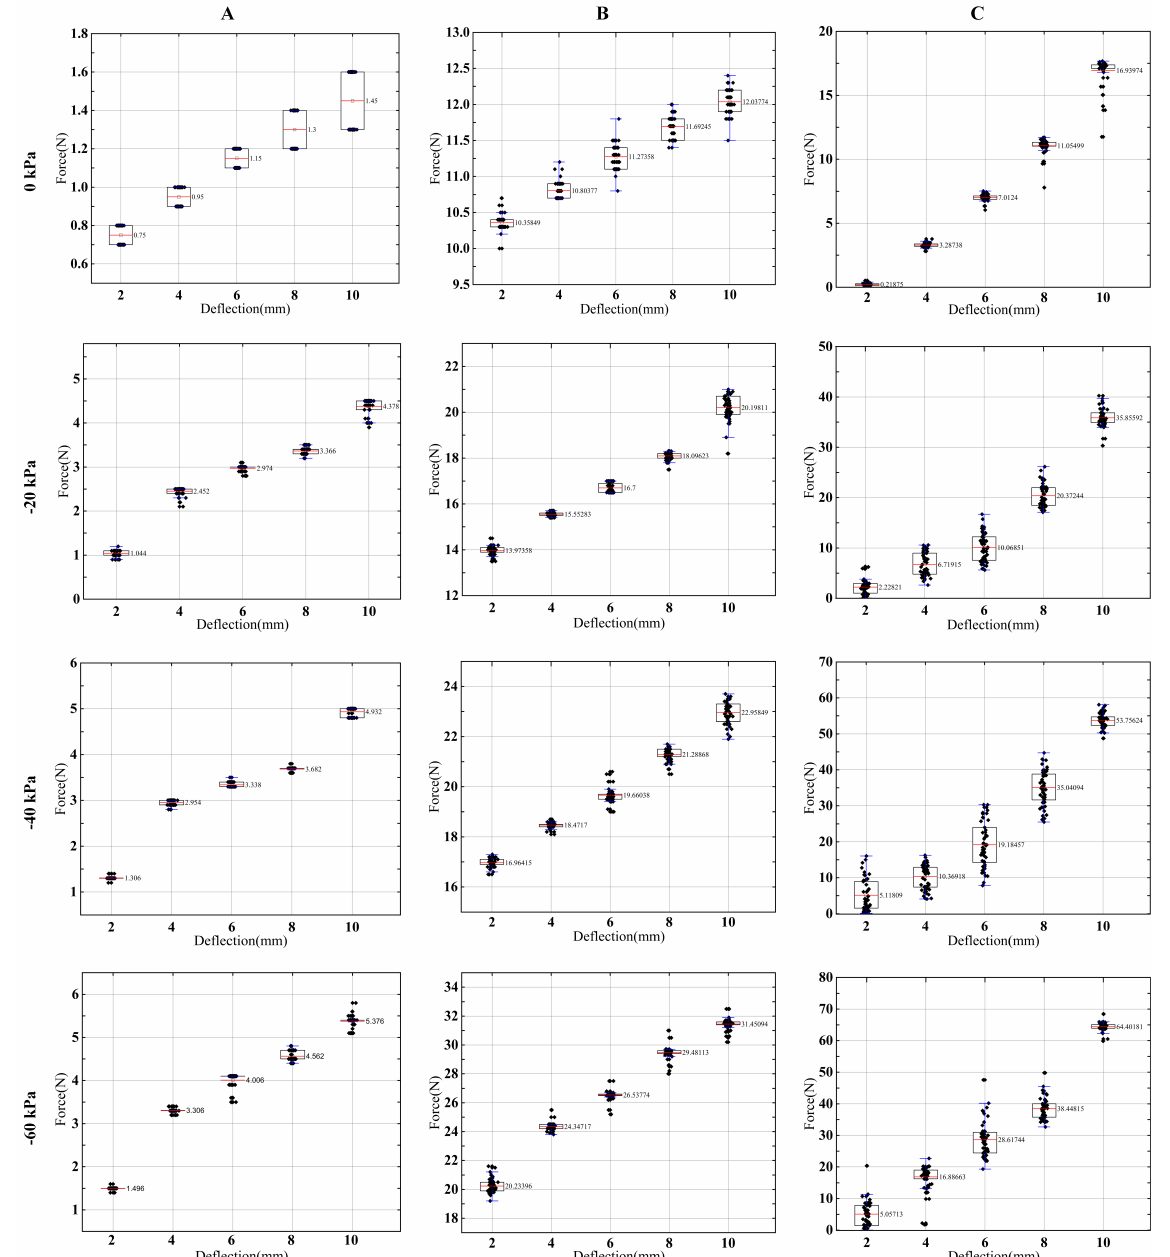
Figure 6. Boxplots of forces displaying the minimum and maximum, the median and the first and third quartile (red line and box) of forces recorded from experimental measurements from 0 kPa to − 60 kPa. ( A ) Compression experiment with straight TSCR (left column). ( B ) Lateral bending experiment at 90° (middle column). ( C ) Lateral bending experiment at 0° (right